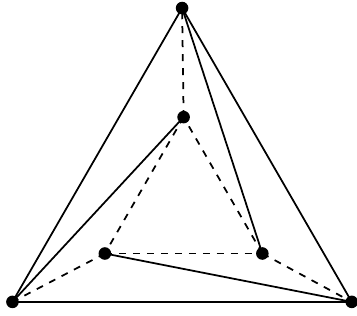
Figure 1: The signed graph for Example 3.1. Negative edges are